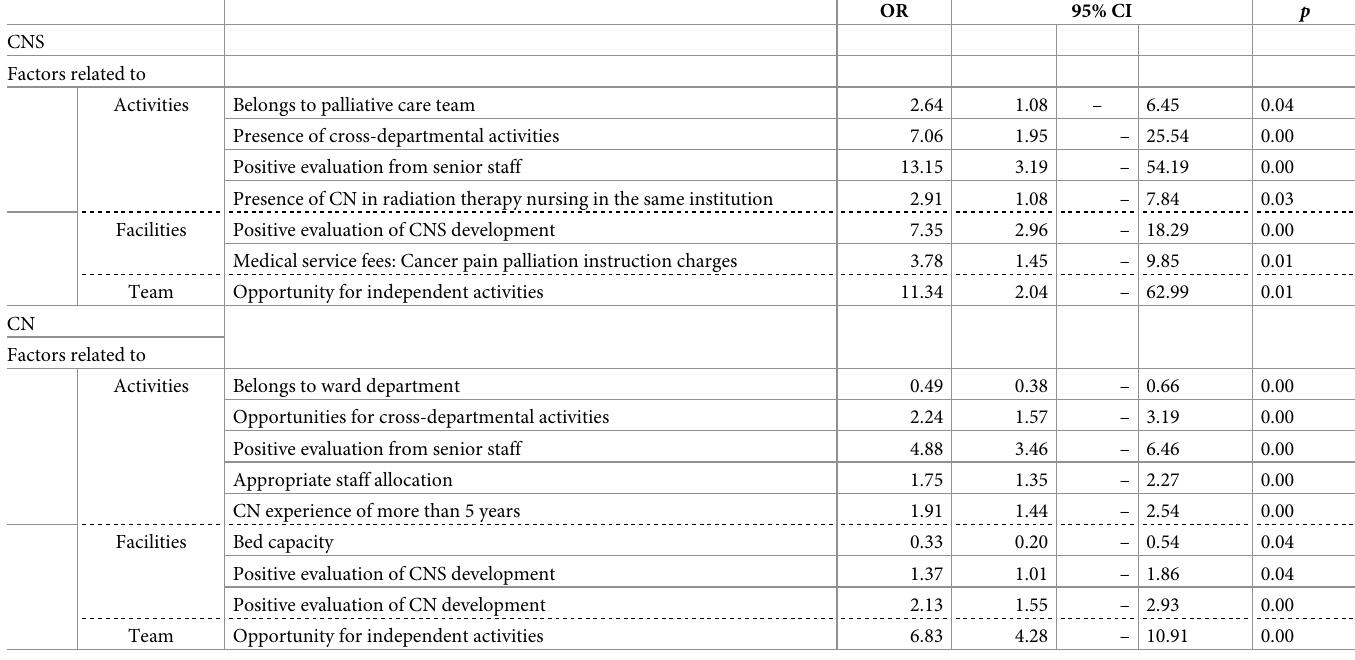
Table 5. Logistic regression